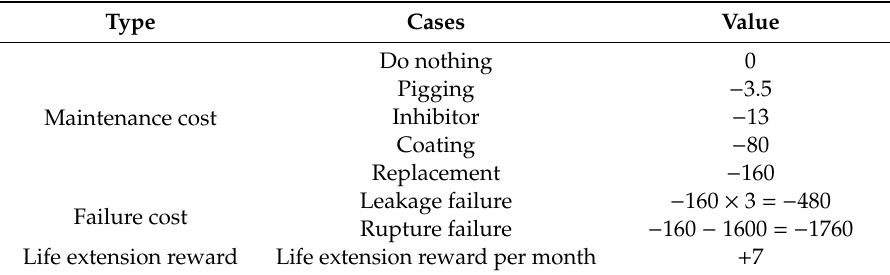
Table 4. Values of reward functions for di ff erent types of costs in the unit of USD